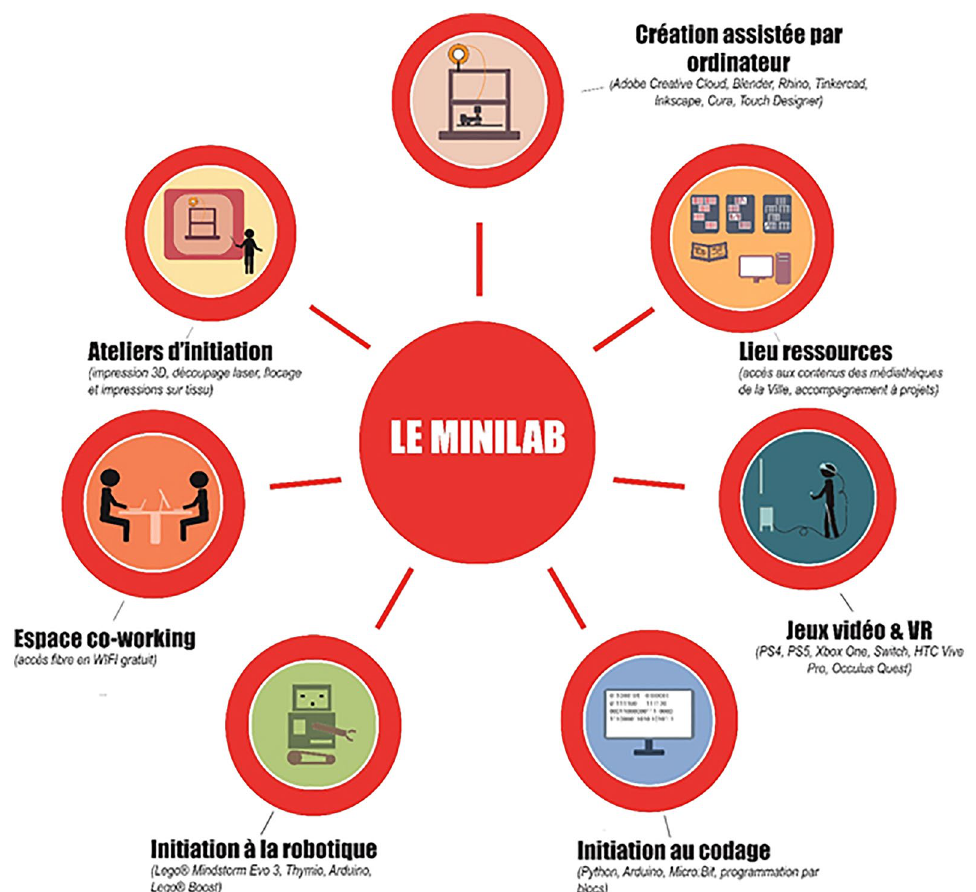
Fig. 5 Example of different activities provided by the Minilab inside “Le temps des